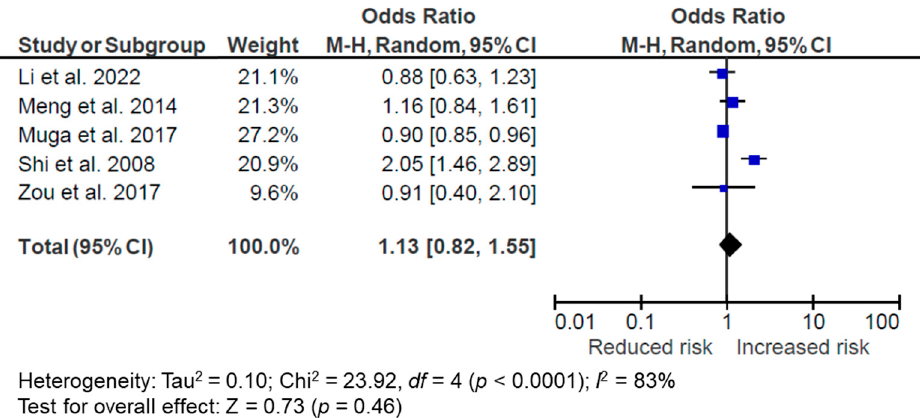
Figure 6. Forest plot of pooled odds ratios (ORs) with 95% confidence interval (CI) for the highest versus lowest quantile of the meat/animal protein dietary pattern for overweight/obesity